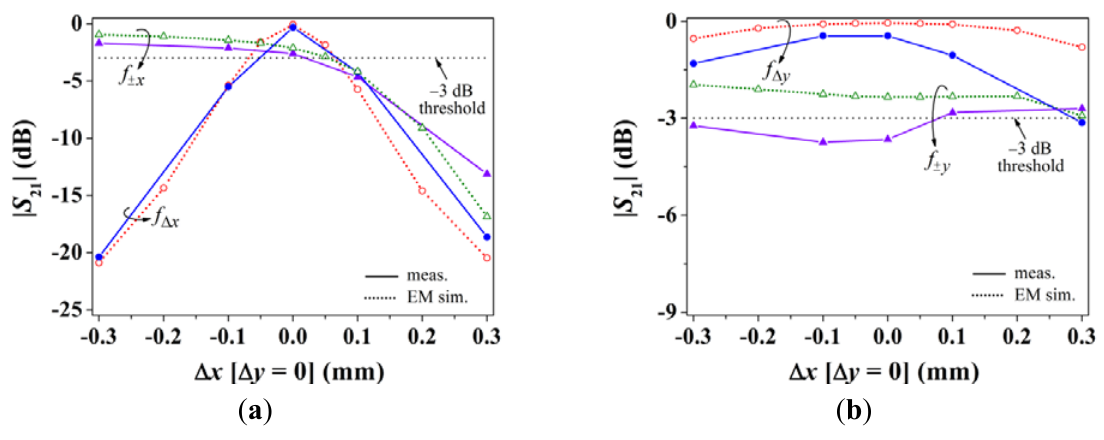
Figure 6. Notch magnitude of the transmission coefficient S for x -oriented displacement; results for ( a ) x - and ( b ) y -axis position sensing.